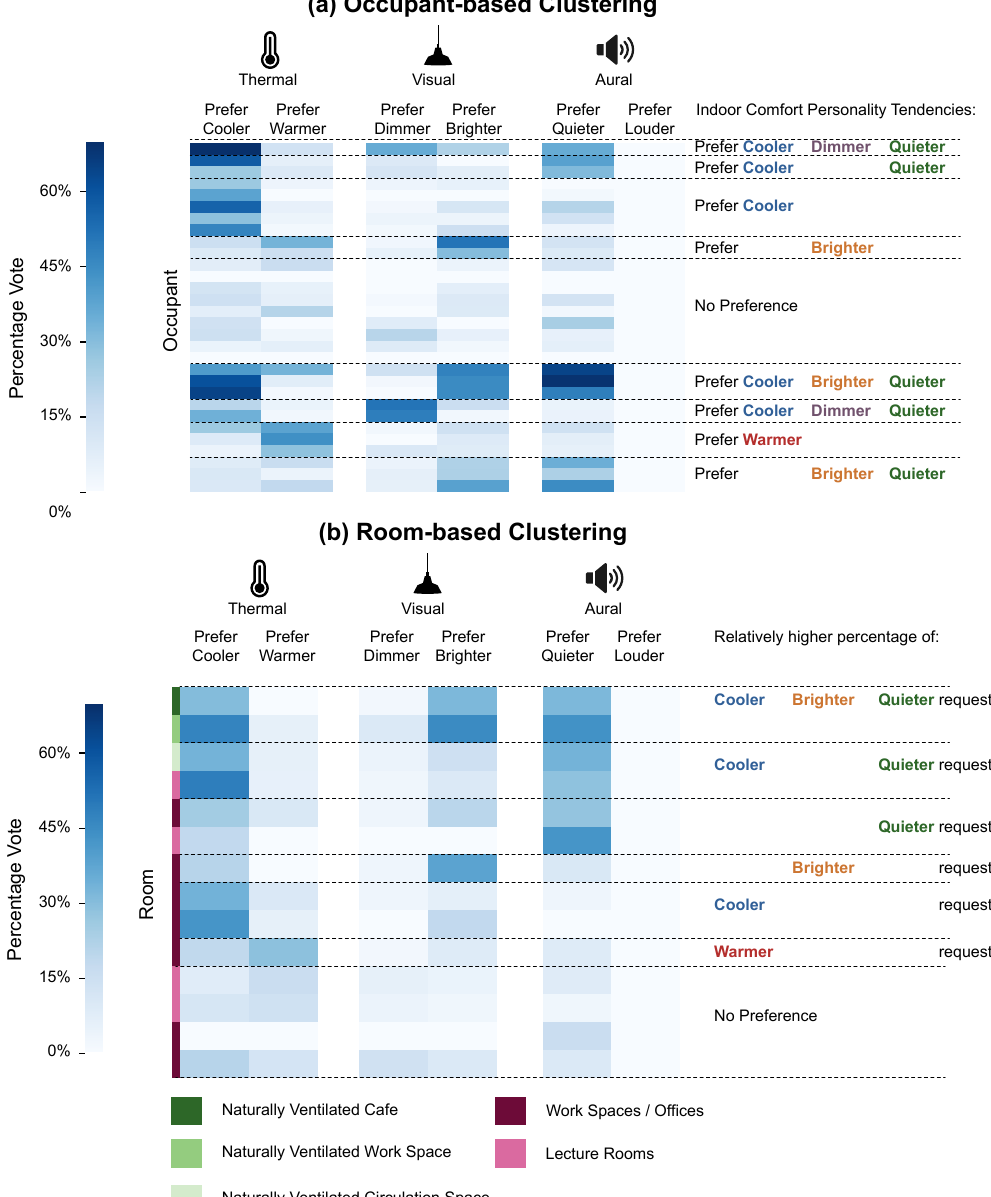
Figure 5. K-means clustering of preference tendencies quantified by average number of votes by occupant ( a ), and by room ( b ) within the test building. Each row presents the percentage of votes that fell into a respective preference. Dark colours in cells indicate higher